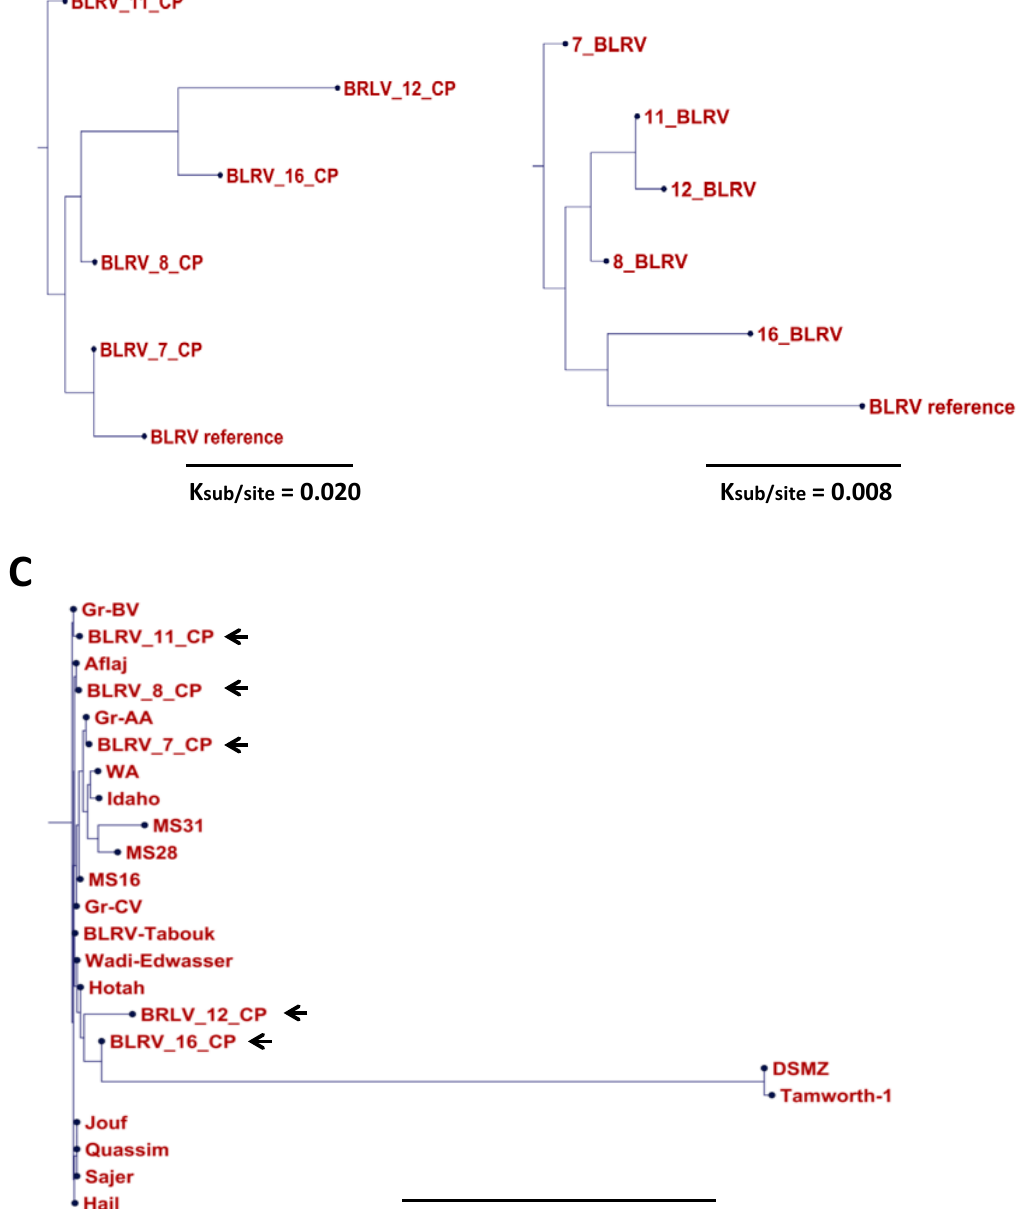
K sub/site = 0.180 Figure 3. A) Phylogenetic analysis of the Bean leafroll virus (BLRV) CP sequences of the Greek isolates, B) Phylogenetic anal- ysis of the 3' untranslated region (UTR) sequences of the Greek isolates, C) Phylogenetic analysis of BLRV CP sequences of the Greek isolates (black arrows) against a collection of BLRV CP sequences from the Genbank: Gr-AA (HE601637.1), Gr-BV (HE601636.1), Gr-CV (HE601635.1), Idaho (GQ404380.1), WA (HM439776.1), Wadi-Edwasser (KJ847775.1), Tabouk (KJ847774.1), Aflaj (KJ847768.1), MS31 (HQ840725.1), MS28 (HQ840724.1), MS16 (HQ840723.1), Hotah (KJ847770.1), DSMZ (GU002353.1), Tamworth-1 (GQ906583.1), Jouf (KJ847771.1), Hail (KJ847769.1), Sajer (KJ847773.1), Quassim (KJ847772.1). Full BLRV sequence (BLRV-Michigan: NC-003369.1 =